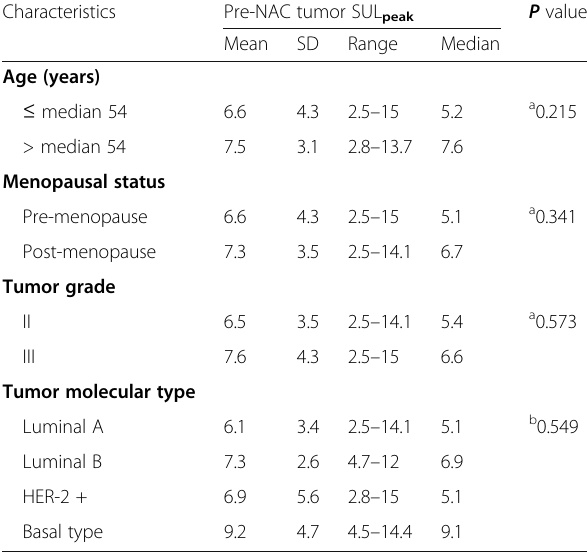
Table 6 Relationship between demographic/histopathologic features and pre-NAC tumor SUL peak Characteristics